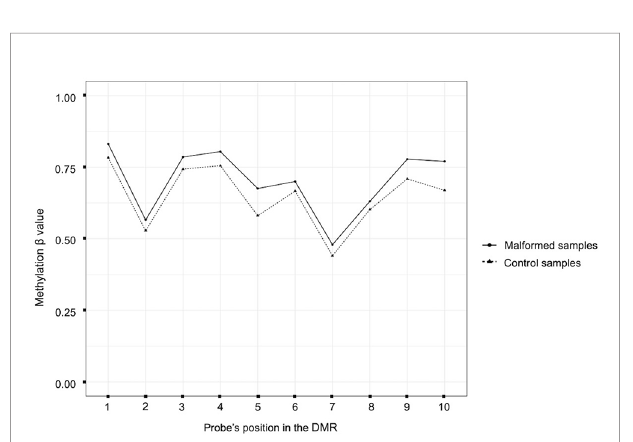
FIGURE 2 | Plot of the beta methylation values (Y axis) of each probe (X axis) of the DMR located near the gene ZFP57. The beta values range from 1 (completely methylated) to 0 (completely unmethylated). The position of the probes inside the DMR is ordered according to their genomic position.